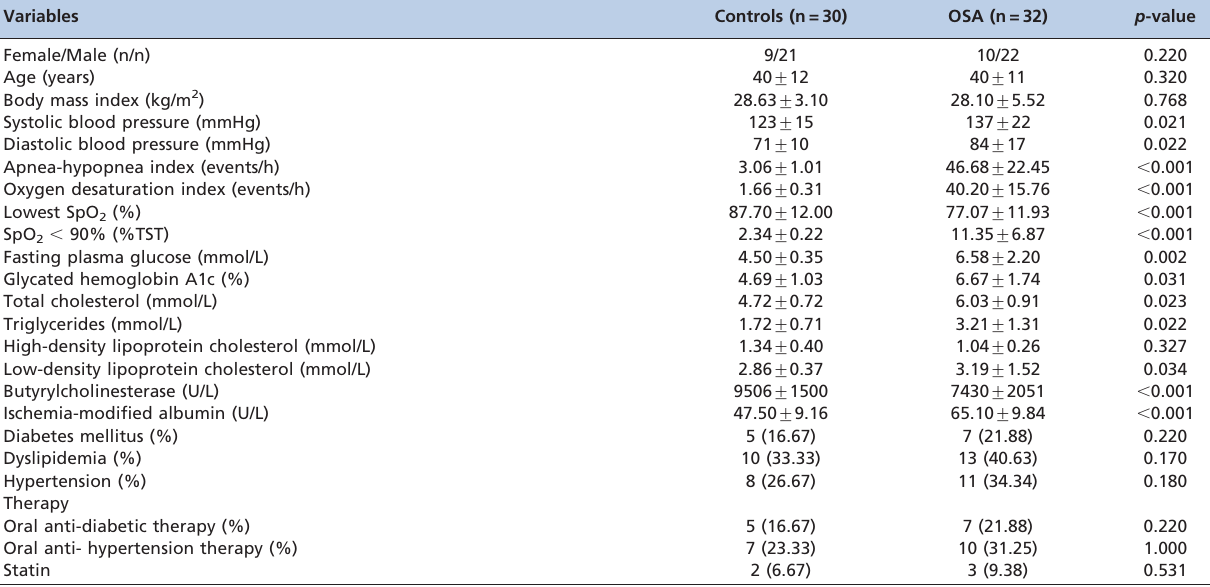
Table 1 - Clinical and biochemical characteristics of the study participants. Variables